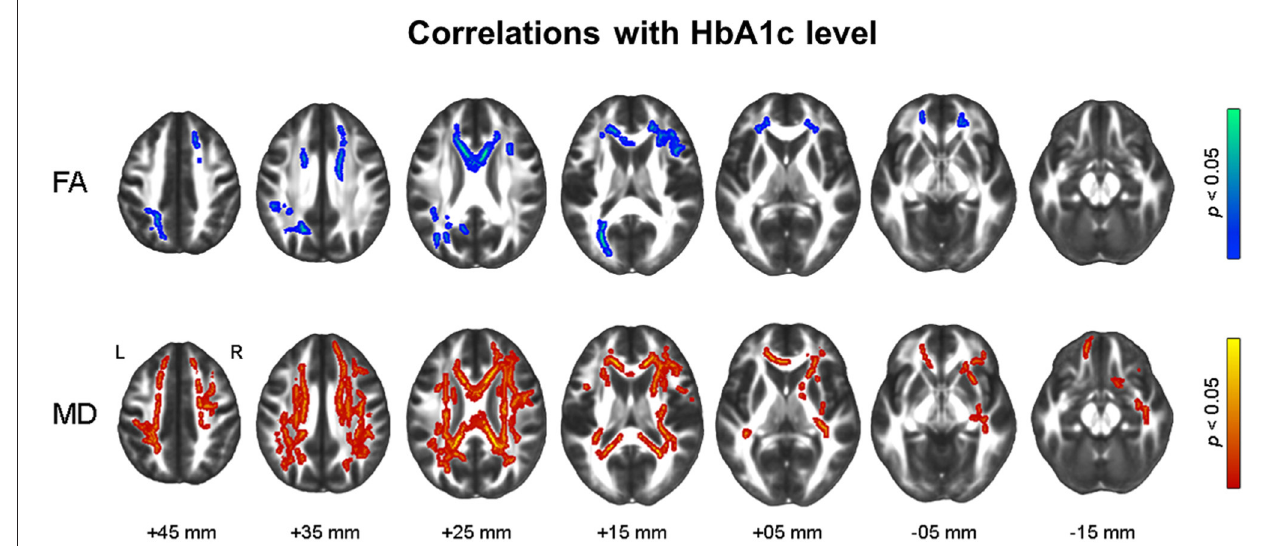
FIGURE 4 | Results of tract-based spatial statistics analysis showing correlations with HbA1c level in dysglycemia. Threshold-free cluster enhancement and family-wise corrected p < 0.05 using nonparametric test. Red indicates a positive relationship, and blue a negative relationship of microstructural measures with HbA1c. HbA1c, glycosylated hemoglobin; FA, fractional anisotropy; MD, mean diffusivity.